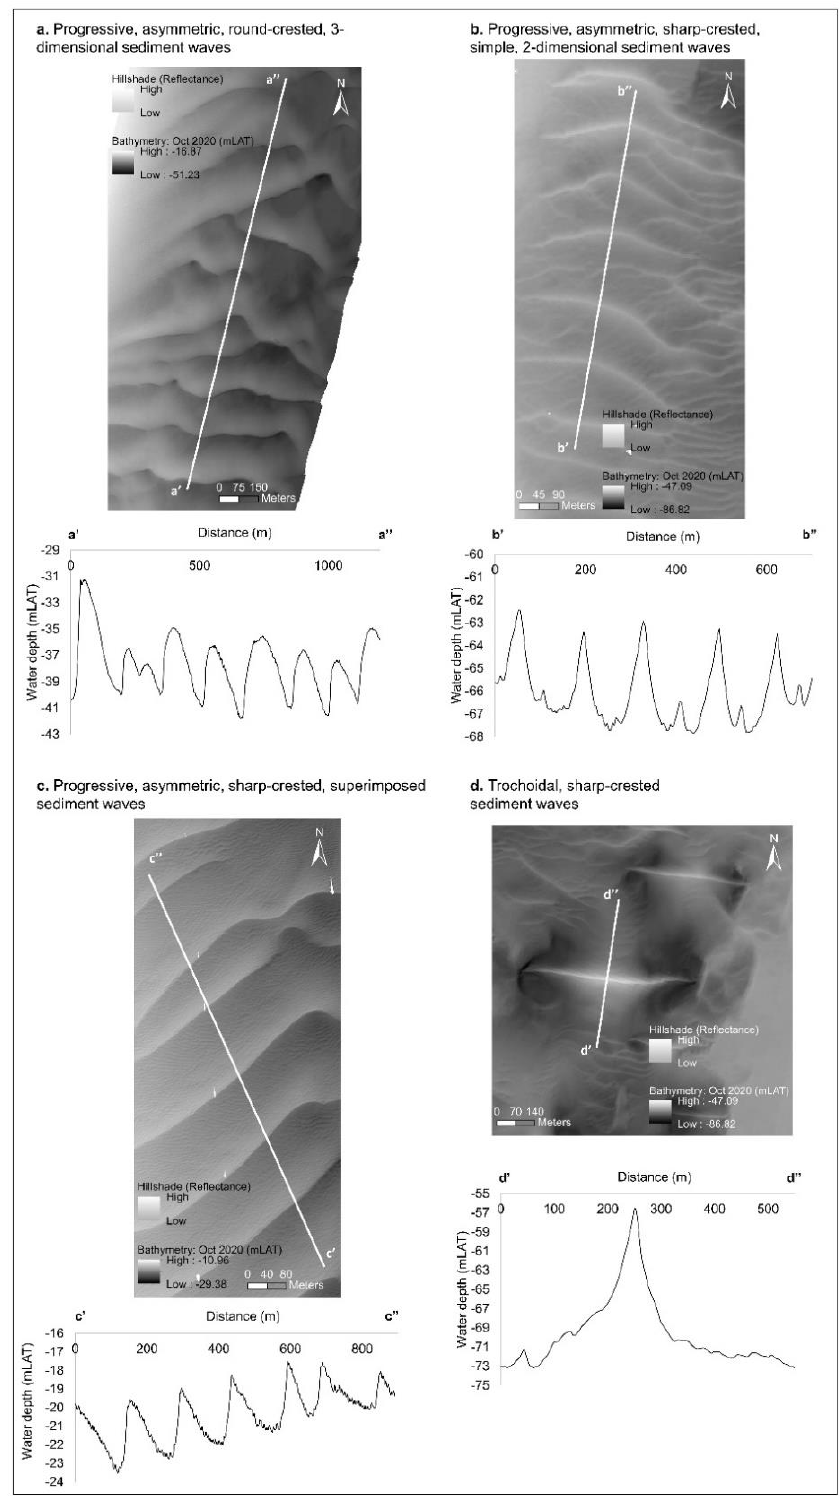
Figure 5. Selection of sediment wave types observed in the south-western Irish Sea; a . progressive, asymmetric, round-crested, 3-dimensional sediment waves, b . progressive, asymmetric, sharp- crested, simple, 2-dimensional sediment waves, c . progressive, asymmetric, sharp-crested, super- imposed sediment waves, and d . trochoidal, sharp-crested sediment waves. A representative cross-section is given for each type. Locations are given in Figure 4. Bathymetry source: MOVE 2020 survey (see site 1A, 6, and 3A in Table